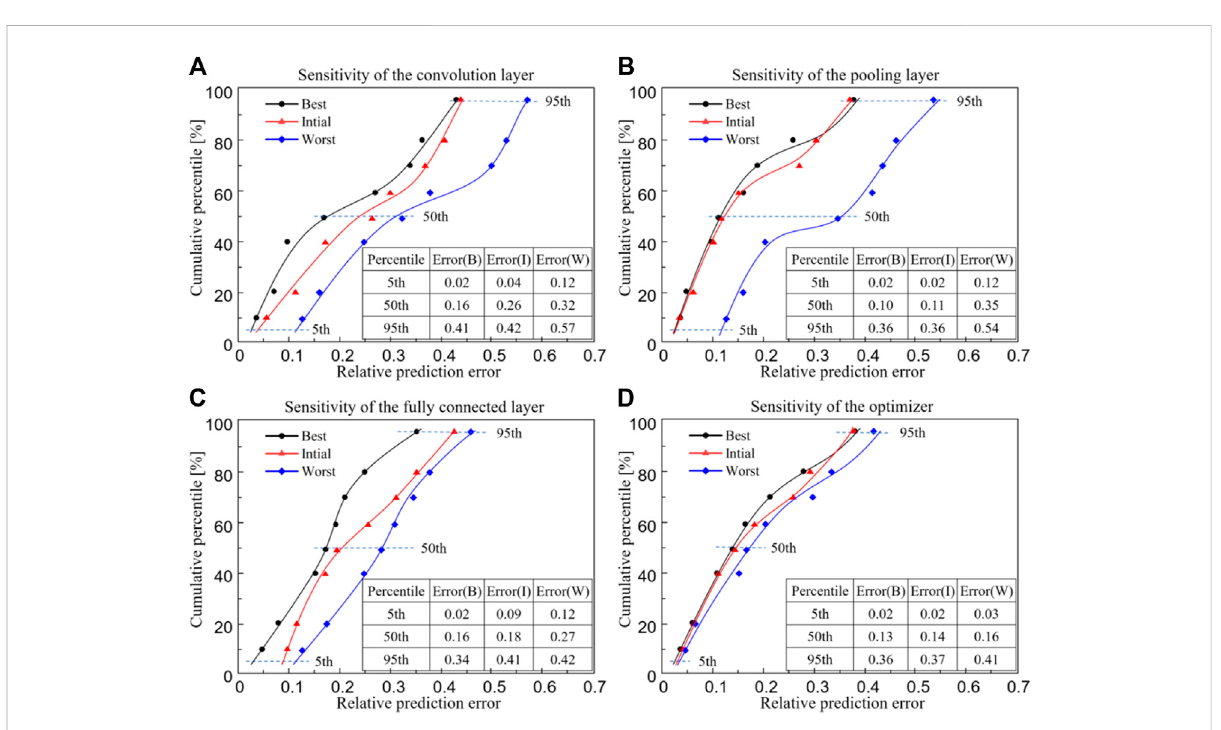
FIGURE 7 The relationship between the cumulative percentile and the relative prediction error from the convolutional neural network model. (A) Sensitivity of the convolution layer; (B) Sensitivity of the pooling layer; (C) Sensitivity of the fully connected layer and (D) Sensitivity of the optimizer ( ‘ Best ’ refers to the case with the lowest 95th percentile of relative prediction error and the corresponding best parameters are listed in Table